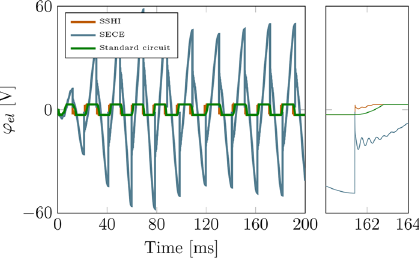
Fig. 12 Electrode voltage 𝜑 el of the bimorph PVEH with stand- ard, SSHI and SECE circuit under a harmonic base acceleration of 9.81 m/s 2 and a frequency of 48.7 Hz